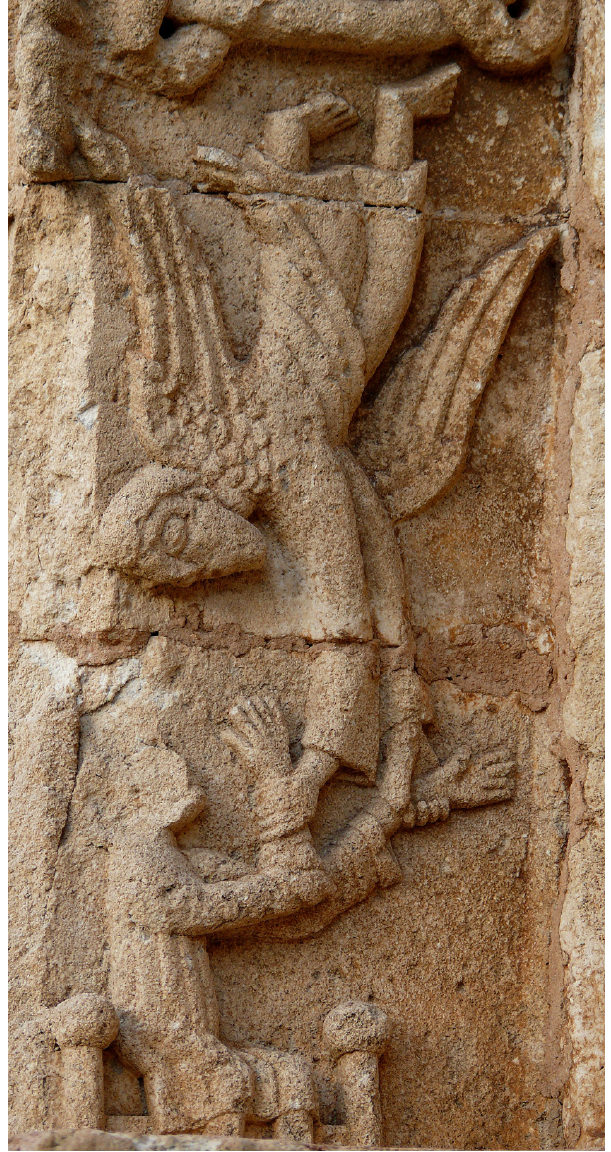
Figure 21. Angel lifting a seated man, detail of the inner fold of the archivolt, west façade, Saint-